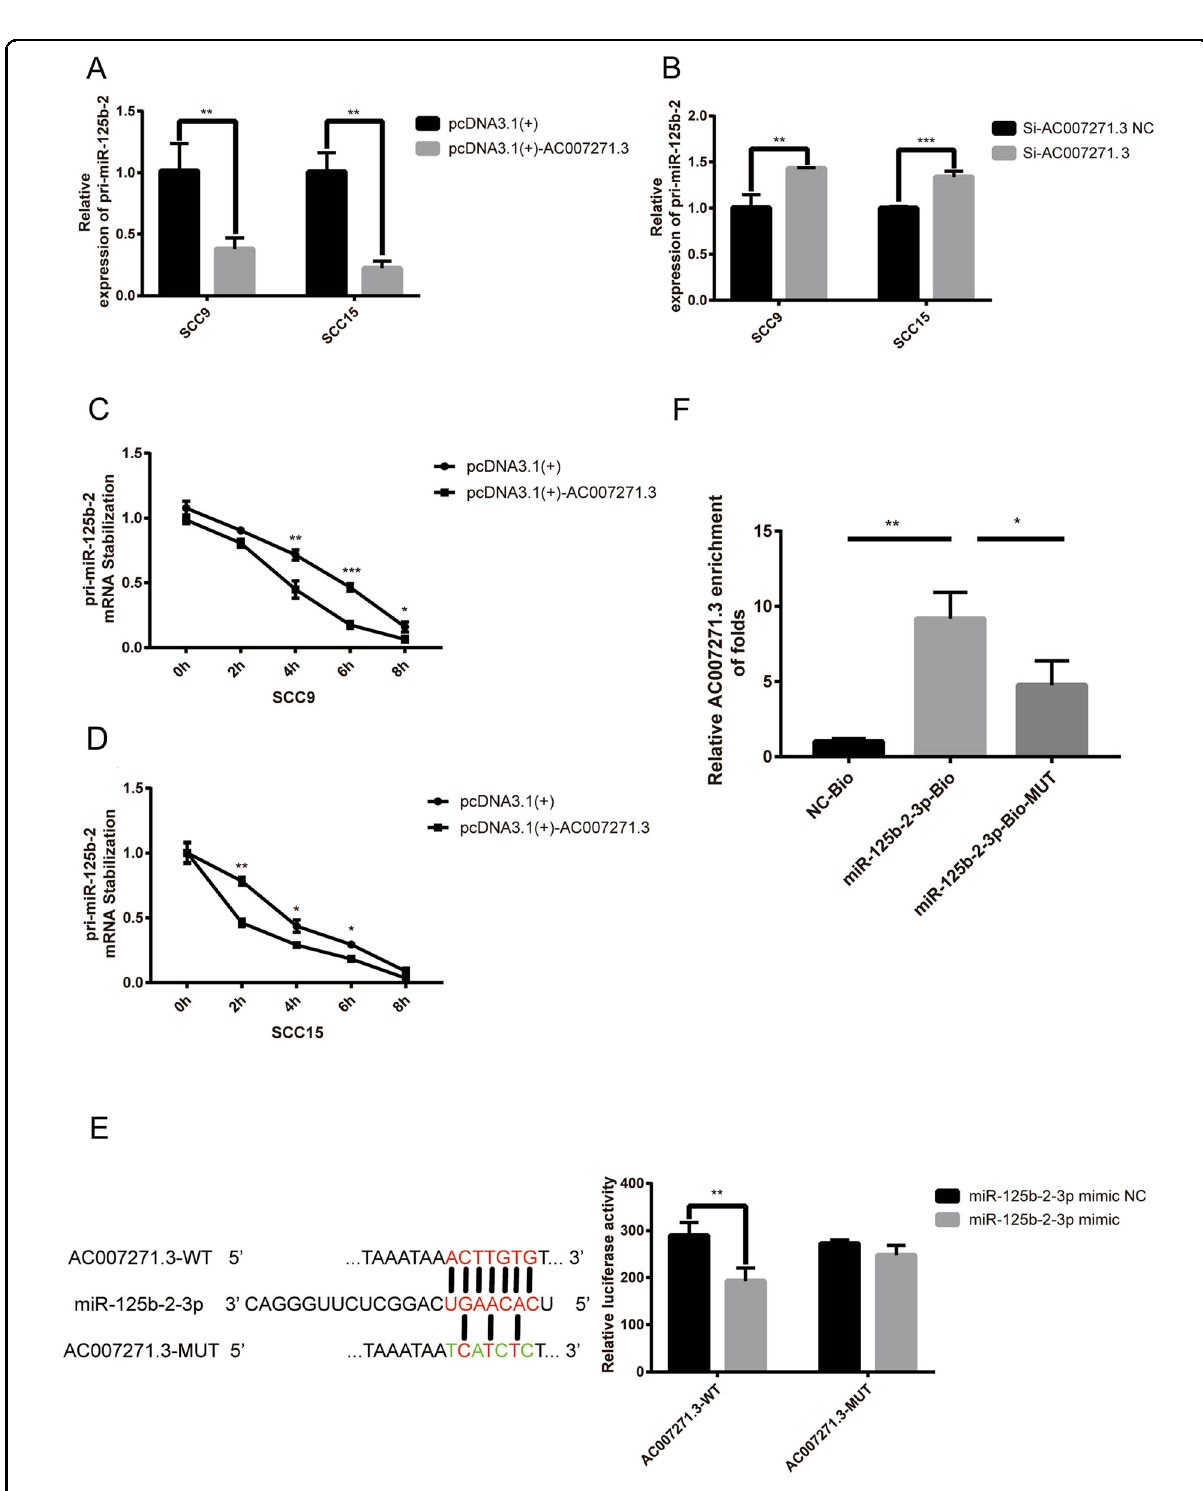
Fig. 2 AC007271.3 interacts with mature miR-125b-2-3p and destabilizes the pri-miR-125b-2 transcript. a Levels of pri-miR-125b-2 after overexpressing AC007271.3 in SCC9 and SCC15. b Levels of pri-miR-125b-2 after knocking down AC007271.3 in SCC9 and SCC15. c – d Stability of the pri-miR-125b-2-3p mRNA after AC007271.3 overexpression were examined at different times (0 h, 2 h, 4 h, 6 h, 8 h) after treating with actinomycin D (5 μ g/mL) in SCC9 and SCC15. e MiR-125b-2-3p overexpression reduced the relative luciferase activity in AC007271.3-WT but not in AC007271.3-MUT. f RNA pulldown assay indicated the direct interaction between miR-125b-2-3p and AC007271.3 in SCC9. * p < 0.05, ** p < 0.01, *** p <